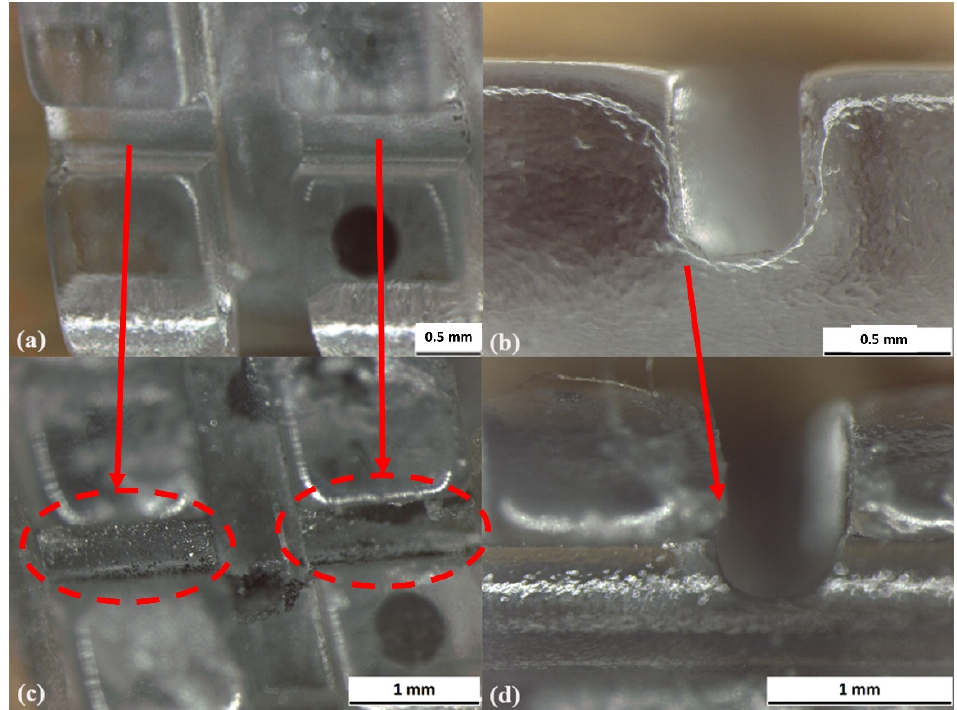
Figure 3. Radiance bracket (American Orthodontics) in top and side view: ( a , b ) before the test; ( c , d ) after the test.